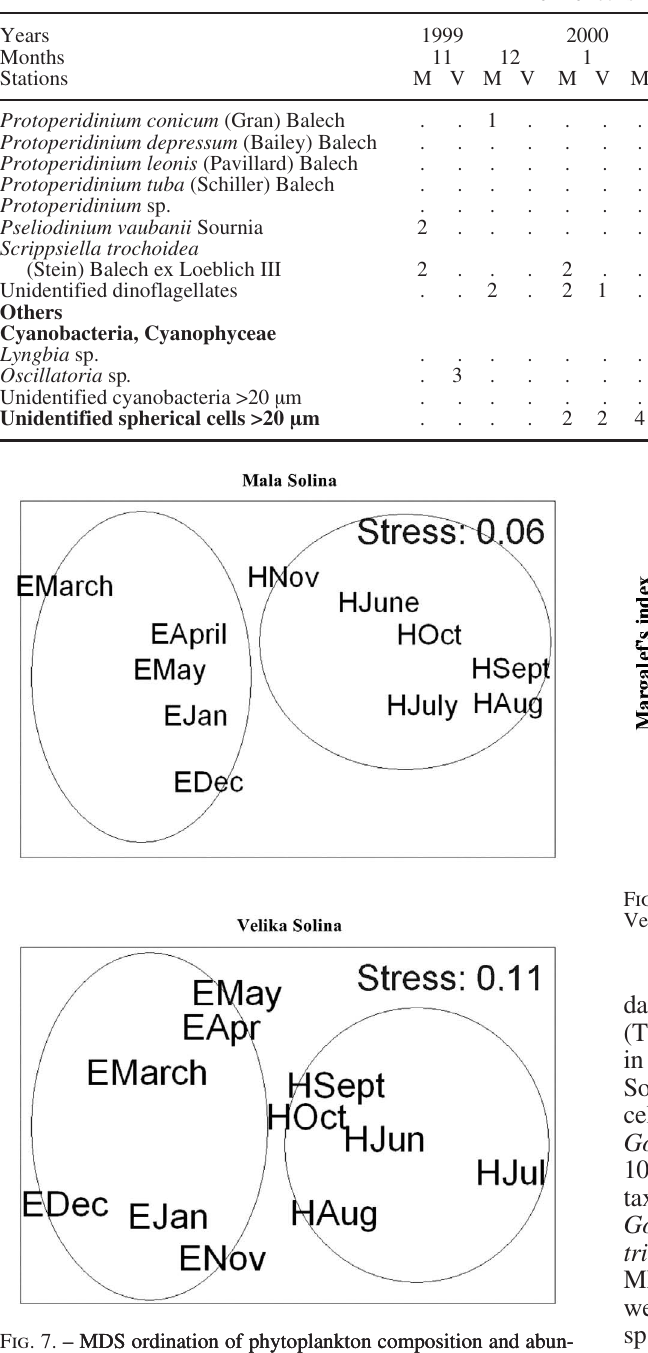
Table 1 (cont.). – List of microphytoplankton taxa and monthly distribution of their abundance in Mala Solina (M) and Velika Solina (V) during the one-year investigation. Abundances are presented as follows: 1 = 10-10 2 ; 2 = 10 2 -10 3 ; 3 = 10 3 -10 4 ; 4 = 10 4 -10 5 ; 5 = 10 5 -10 6 ; 6 =